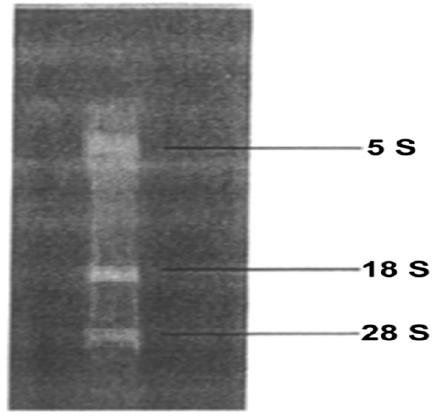
Figure 1. Total RNA integrity